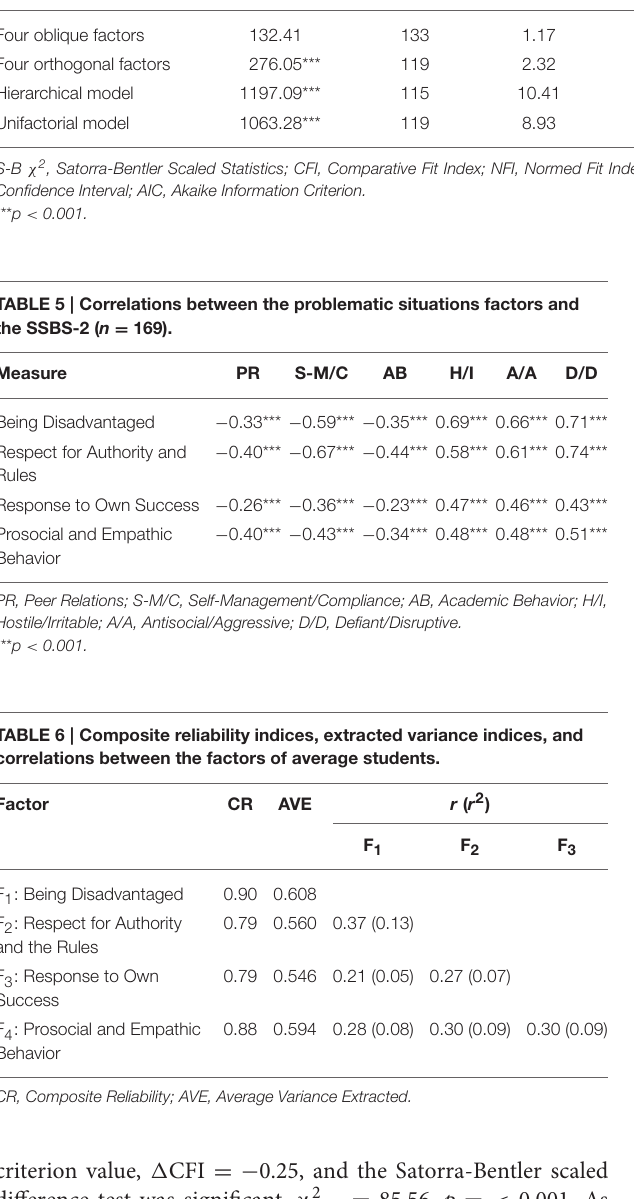
TABLE 4 | Goodness-of-fit indexes of the four possible models. Model